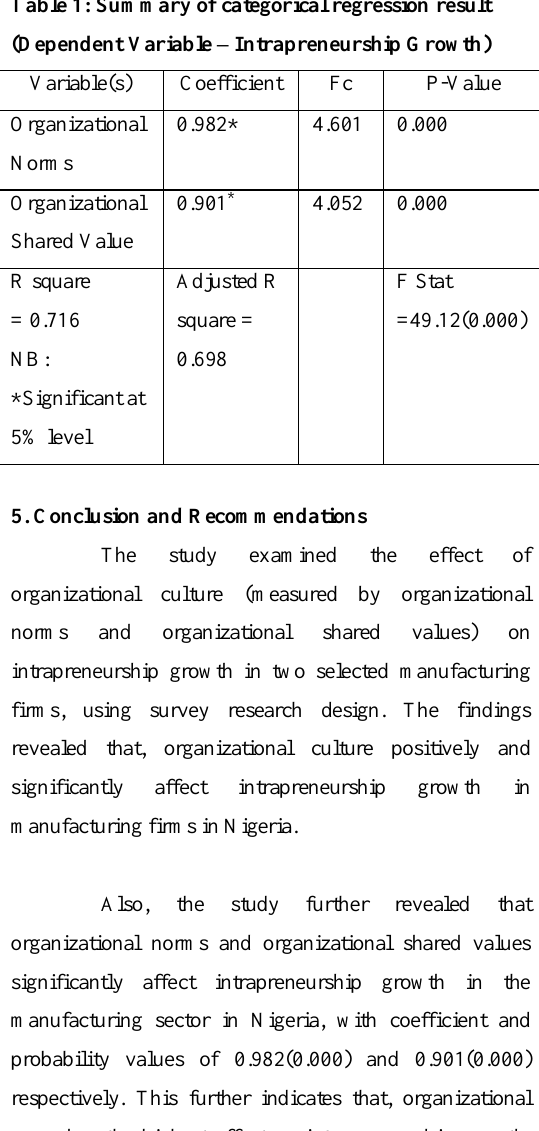
Table 1: Summary of categorical regression